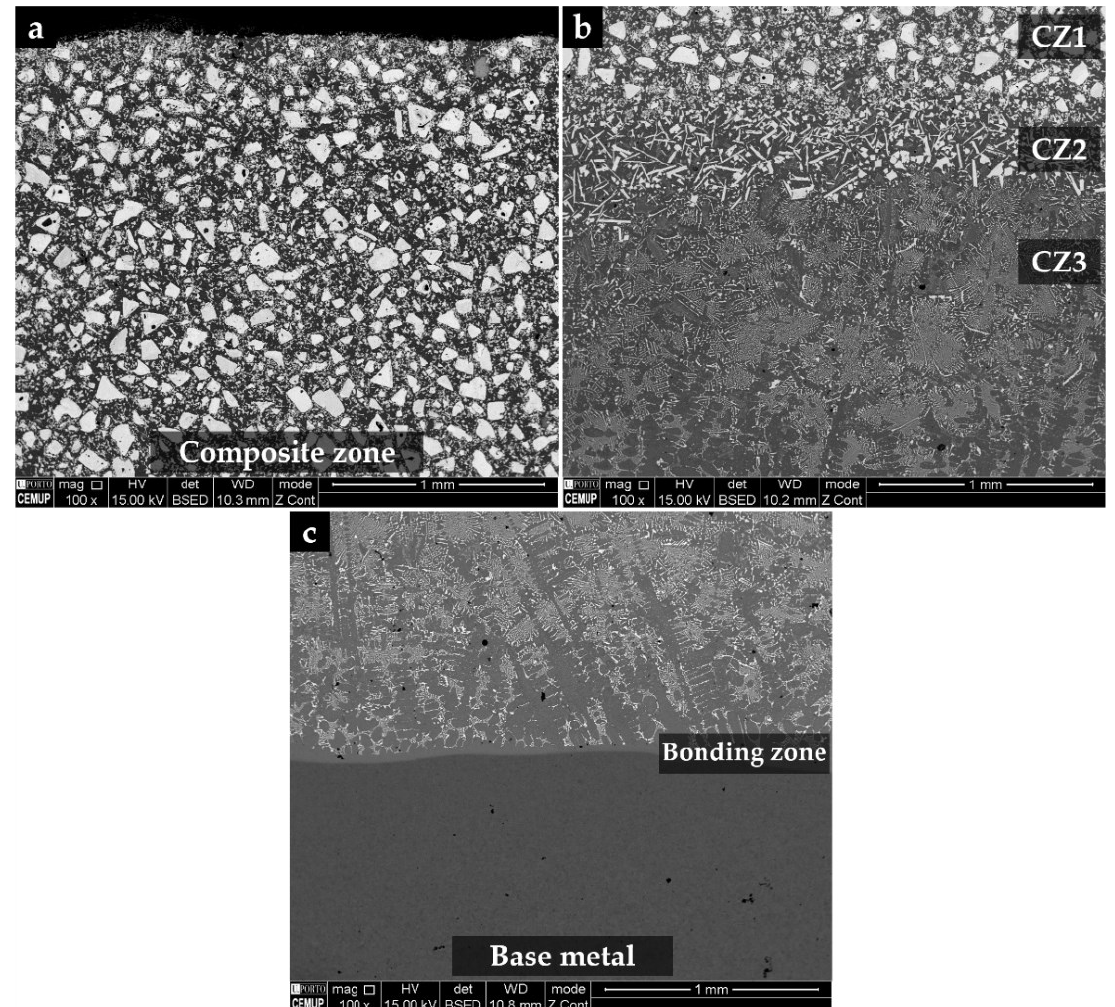
Figure 1. SEM – BSE images of the microstructure of the reinforced specimen, showing: CZ1 — nearest Figure 1. SEM–BSE images of the microstructure of the reinforced specimen, showing: CZ1—nearest to the surface ( a ), a transition region, with three distinct zones: CZ1, CZ2 — intermediate, and CZ3 — to the surface ( a ), a transition region, with three distinct zones: CZ1, CZ2—intermediate, and CZ3— next to the base metal ( b ), and the interface with the steel ( c ). next to the base metal ( b ), and the interface with the steel ( c